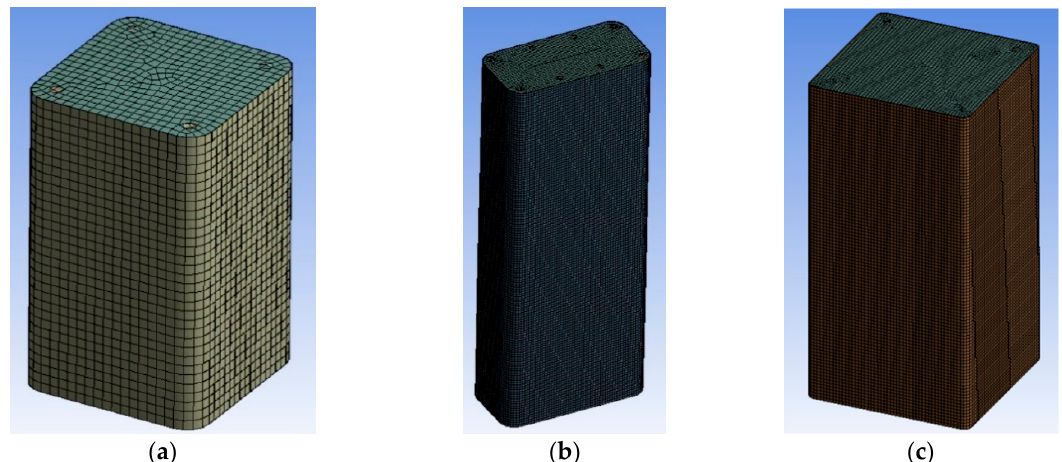
Figure 2. ( a ) “Hexahedral Solid Elements”; ( b ) “Tetrahedral Solid Elements” and ( c ) “Beam (Line) Elements”.